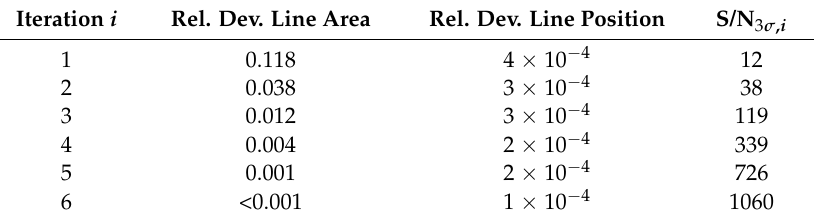
Table 3. Evolution of the relative deviation of absorption line area A i and position mi from the prescribed ‘true’ values together with the signal-to-noise ratio S/N 3 σ , i for each iteration of the AI fit. This table is from